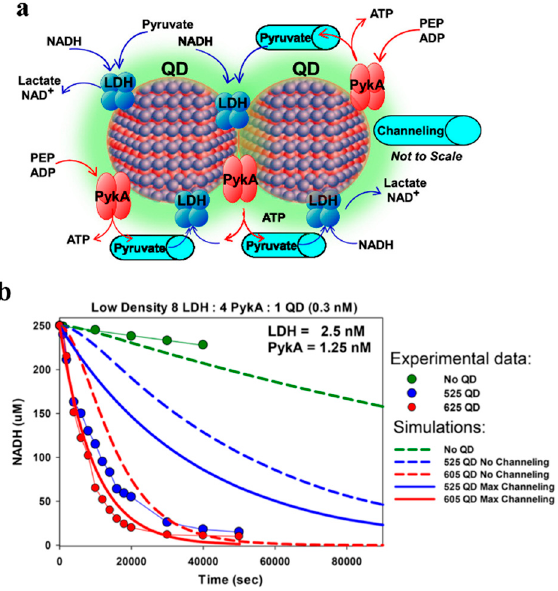
Figure 8. Enhancement of enzymatic activity with QDs. ( a ) Schematic of the coupled PykA − LDH enzyme system colocalized on a QD surface. The propensity of the enzymes to form cross-linked QD dimers and, to a lesser extent, trimers via the enzymes tetrameric polyhistidine tags is also schematically indicated. Note, not to scale. ( b ) Comparison of experimental data following sample NADH consumption with predictions of a kinetic model of the PykA / LDH cascade. The experimental data are denoted as points connected by thin lines of the same color, and the simulation results are given by thicker solid or dashed lines. The model and its kinetic parameters are discussed in the text including the approach used to simulate “Max channeling”. Reprinted (adapted) with permission from [19]. Copyright 2018 American Chemical Society, Washington, D.C., USA. Table 6. Overview of representative QD-immobilized enzymes.